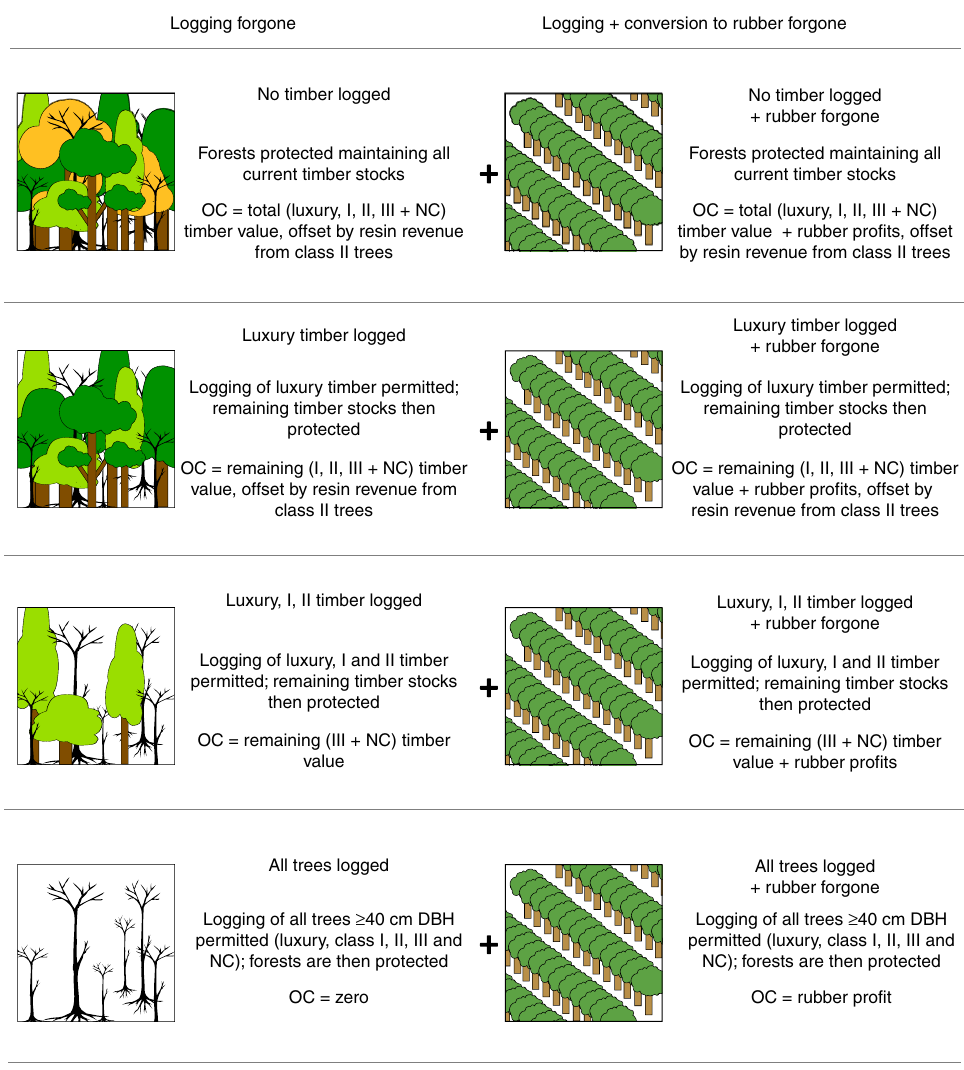
Fig. 1 Scenarios of intervention to protect forest from conversion to rubber. Schematic shows scenarios of intervention to protect remaining forest in: initial state ( “ No timber logged ” ); after selective logging ( “ Luxury timber logged ” or “ Luxury, I, II timber logged ” ) and after all trees ( ≥ 40 cm DBH) have been logged ( “ All trees logged ” ). Tree species are assigned to one of four royalty classes: luxury, I, II, III or non-classi fi ed (NC; Supplementary Data 1) based on a governmental list 69 ; collection of luxury timber includes all stems ≥ 10 cm DBH, for other classes stems ≥ 40 cm DBH. “ Timber ” refers to luxury, class I and class II species; class III and NC species are non-commercial, and are thus termed “ trees ” . All resin trees are classi fi ed as class II. The left column considers opportunity costs (OC) of protecting forests following scenarios of logging only, where conversion to rubber is prohibited; the right column considers opportunity costs of protecting forests following scenarios of logging, with the additional opportunity costs of forgone conversion to